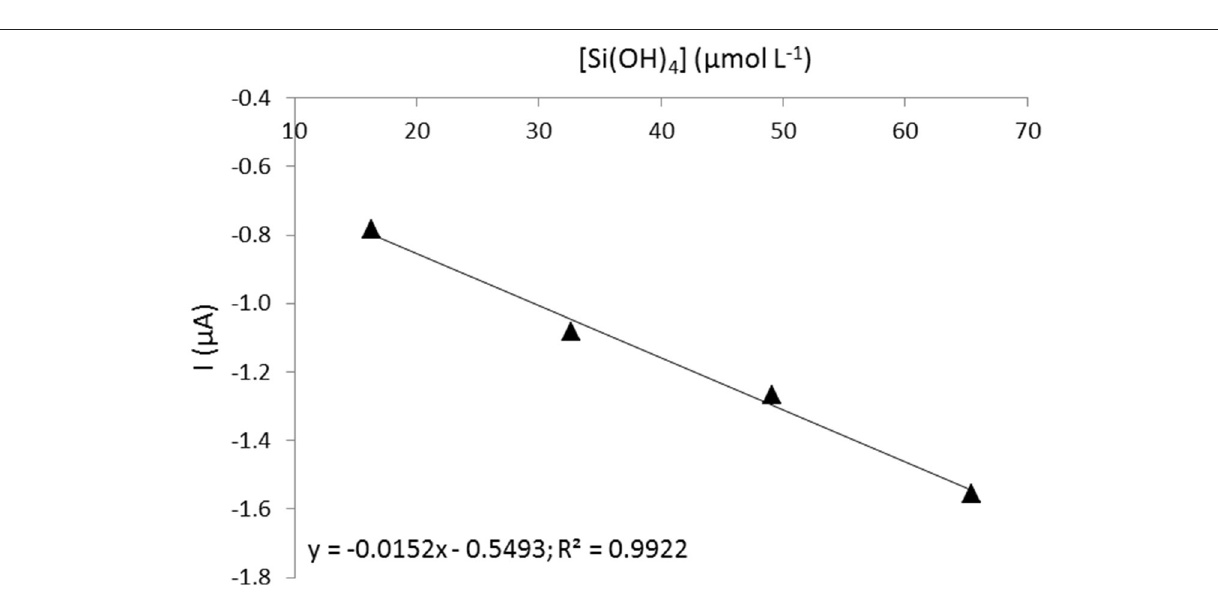
Frontiers in Marine Science |